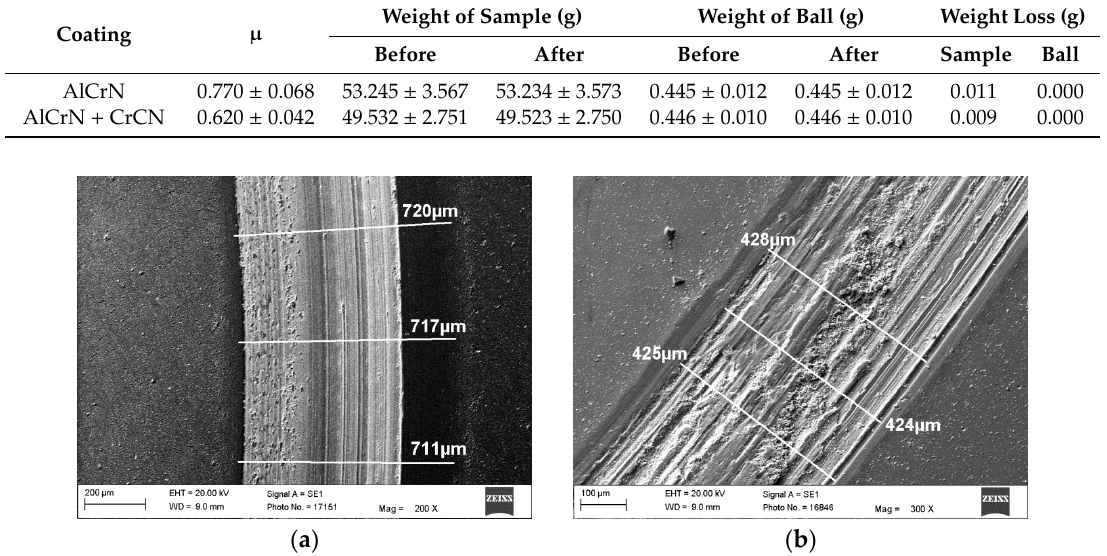
Figure 16. The wear surface topography of the ( a ) AlCrN, ( b ) AlCrN + CrCN coating.